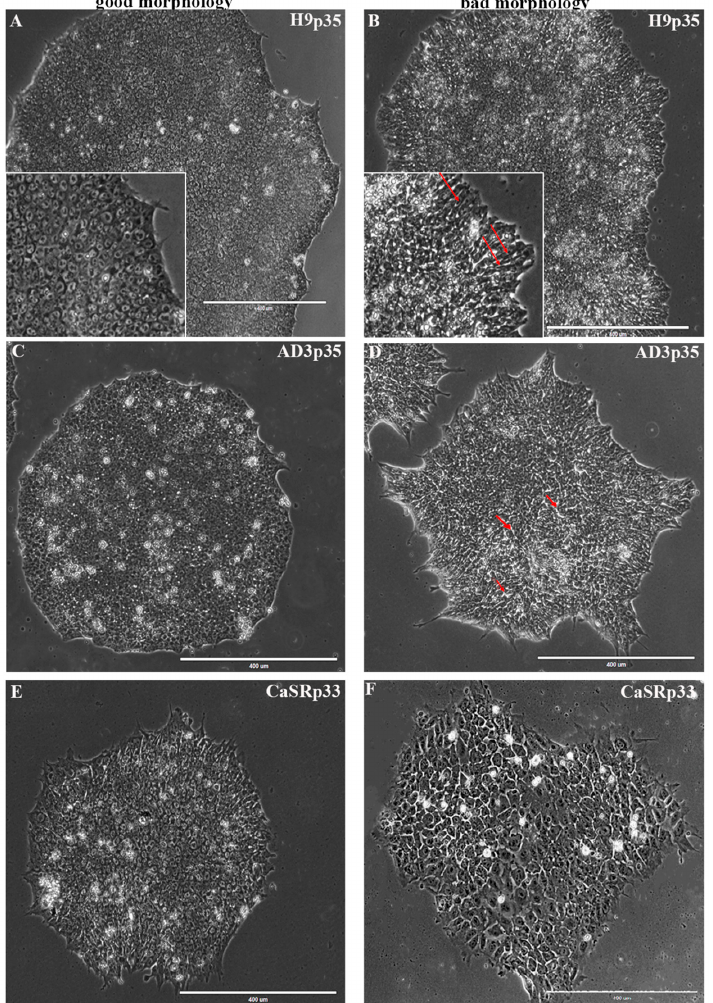
Figure 1. Morphological features of hPSC colonies with good and bad phenotypes at 120 h after plating. Phase-contrast observation. The left panels ( A , C , E ) show typical examples of hPSC colonies of good phenotype without signs of spontaneous differentiation: flat structure, prominent well– defined edge, and a high nuclear-to-cytoplasmic ratio, with prominent nucleoli in square-shaped, tightly packed cells. The right panels ( B , D , F ) show the typical morphology of colonies with bad appearance: altered cell morphology (long arrows indicate elongated cells) and loosely packed cells with phase-bright gaps visible between cells (small arrows). In addition to the lack of dense packing, note the “spiky” colony edge ( D ). For up to 3–4 days after plating, colonies may exhibit looser packing as the colonies spread out and become established. At this point, “spiky” colony edges should not be a cause for concern. The density of the colonies increases rapidly after 72–96 h, and the morphology changes significantly at 120 h, before the next passage. The cell sizes vary greatly ( F ), indicating the beginning of the spontaneous differentiation. Scale bar, 400 μ m.